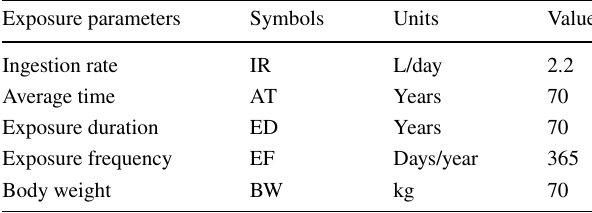
Table 2 Input parameters to characterize the average daily dose value